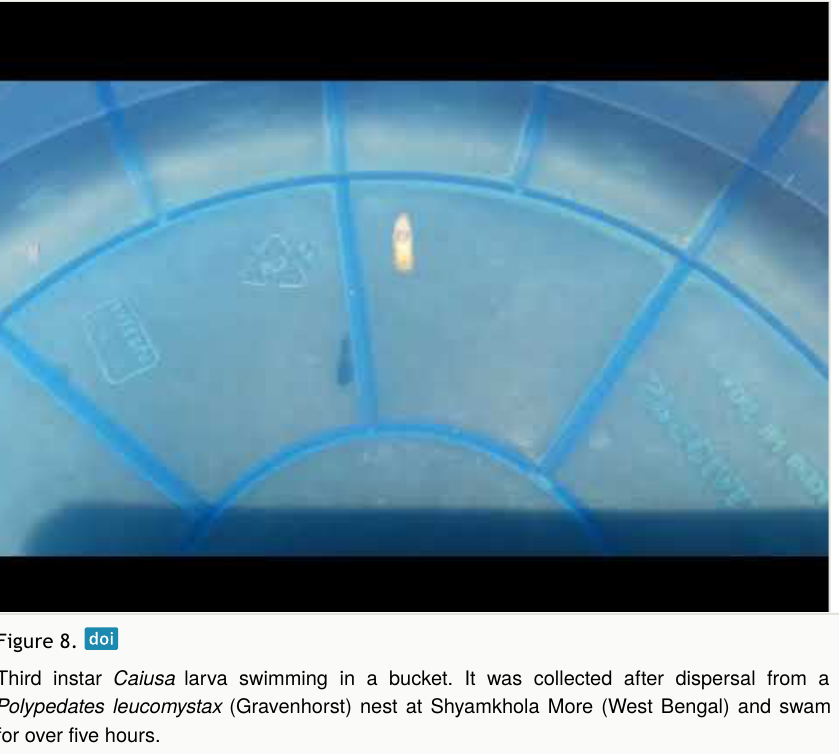
Behaviour of third instar Caiusa larvae. Because the foam nests of rhacophorid frogs are usually hanging from vegetation above the water, the question of how mature Caiusa larvae reach dry land to pupariate has remained open. Observations of C. simus and P. leucomystax nests during this study have provided new information on the dispersal of mature Caiusa larvae from their feeding sites. At Shyamkhola More in September 2011, one larva was observed at night while descending from an outlier C. simus nest (suspended about 1 m above land at a short distance from the pond) by using a thread of unknown nature seemingly secreted by its posterior end (Fig. 6a). A bucket of water was placed below the nest to intercept the larva. After reaching the water, the larva swam to the edge of the bucket (Fig. 7) and slowly climbed out to fi nd a suitable place to pupariate. In early June 2018 a similar behaviour was observed by Caiusa larvae dispersing from a P. leucomystax nest fl oating on the water (Fig. 6b); one larva was placed in a bucket and swam for over fi ve hours (Fig. 8). The e ffi cient swimming mechanism documented in the videos in Figs 7, 8 suggests that this is a habitual behaviour of Caiusa larvae; together with the thread used to reach the water surface, it provides a plausible explanation of how larvae of these blow fl ies reach dry land to pupariate after feeding in foam nests suspended above the water. To our knowledge, this type of swimming behaviour had never been observed in a blow fl y larva before. The swimming ability and relative morphological adaptations (see below) of the larvae are possibly a new synapomorphy of species in this genus of frog predators, but we have no data on the other Caiusa species at present.